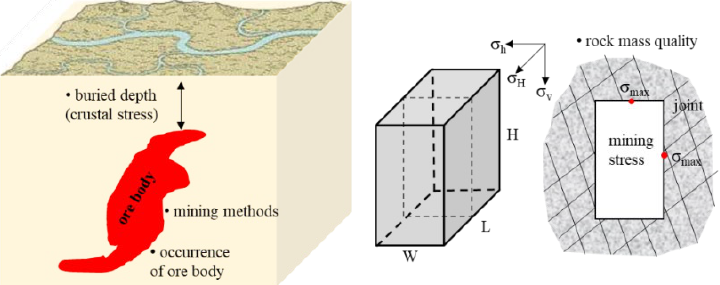
Figure 2. Mechanical model of underground stope.